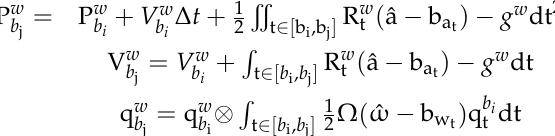
and ; ( d ) the edge point and plane point in and (cid:48)F f . i i 𝑖𝑖𝑓𝑓 ie ℱ ℱ